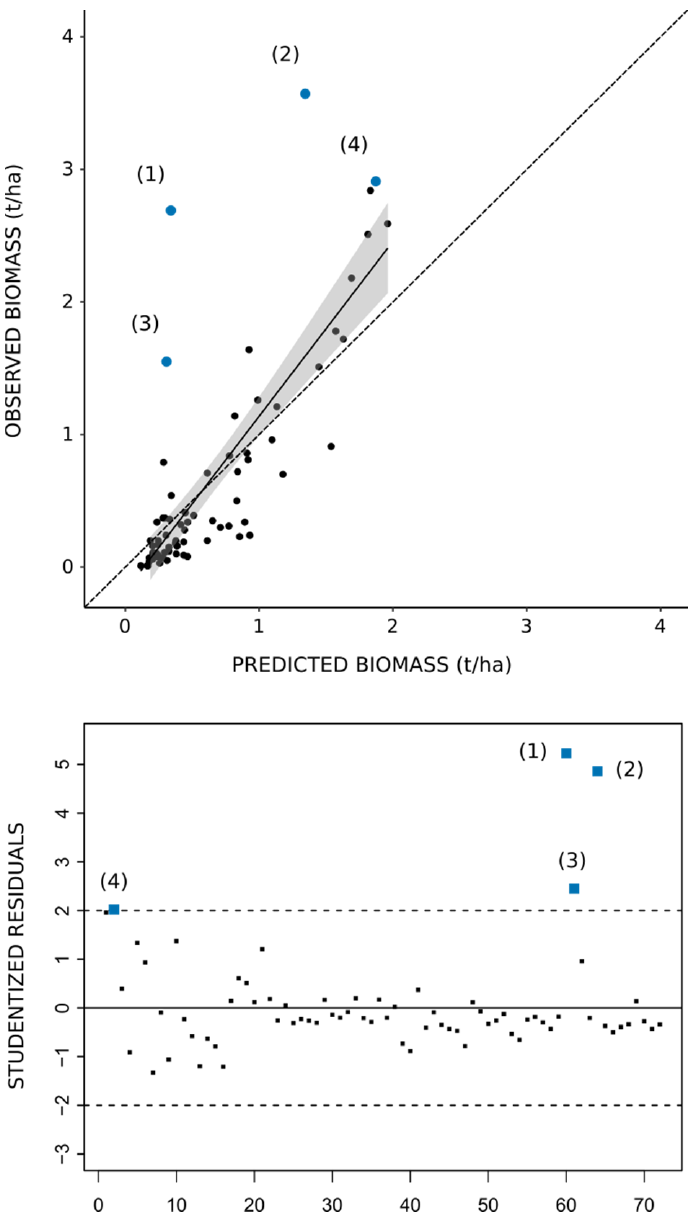
Figure 5. Relationship between observed and predicted biomass values (top), and studentized residuals (bottom) for the validation sample. 1 to 4 (blue squares/bullets): observations characterized by a value of studentized residuals outside the [–2,2] interval (identification of observations in Table 5). Top panel: solid line = linear fit, grey area = 95% confidence interval on the regression line, dashed line = Y = X. (See Figure S4 for a black and white version.).